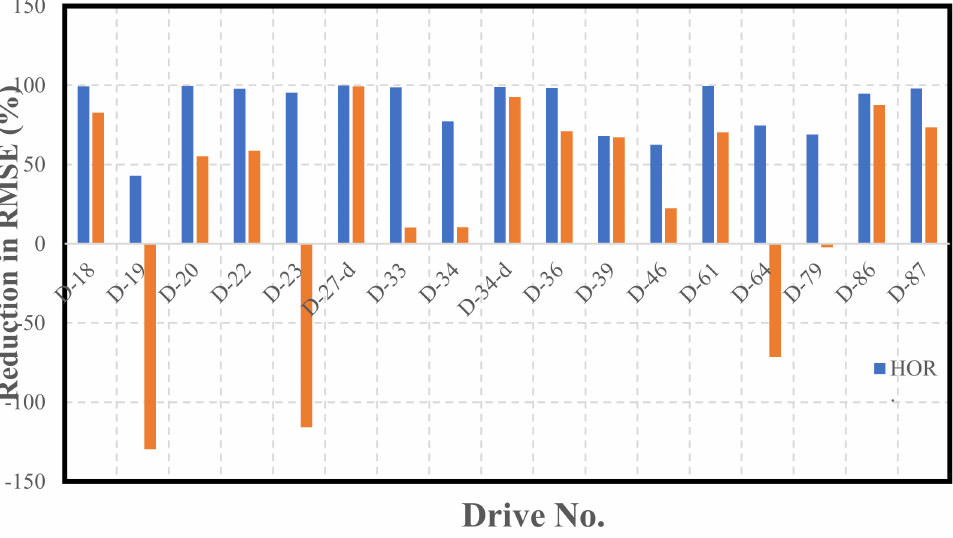
Figure 12. Reductions in RMSE of KITTI residential